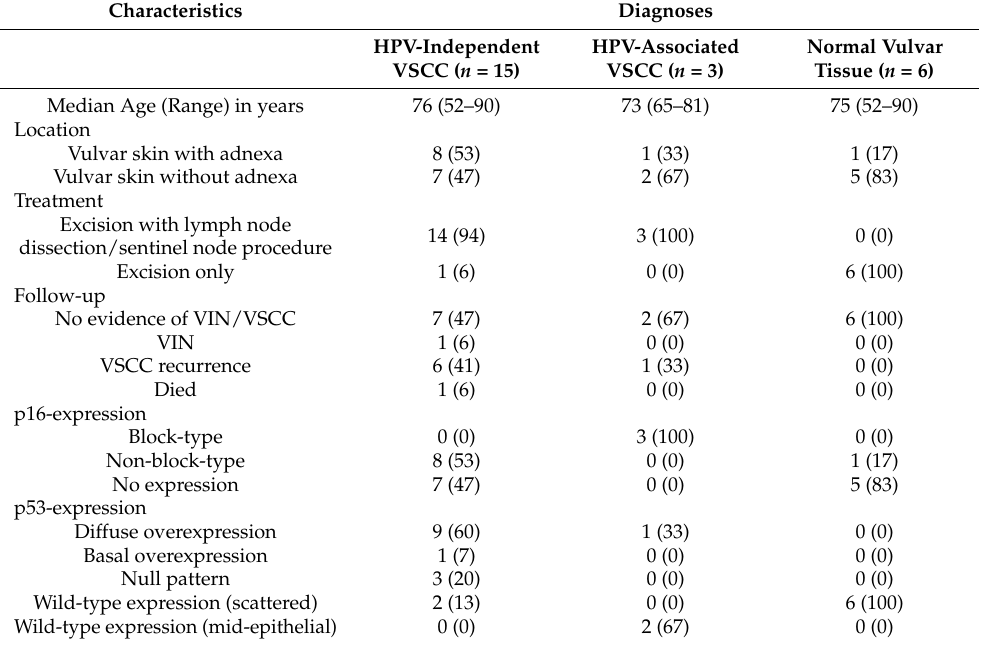
Table 1. Clinico-pathological